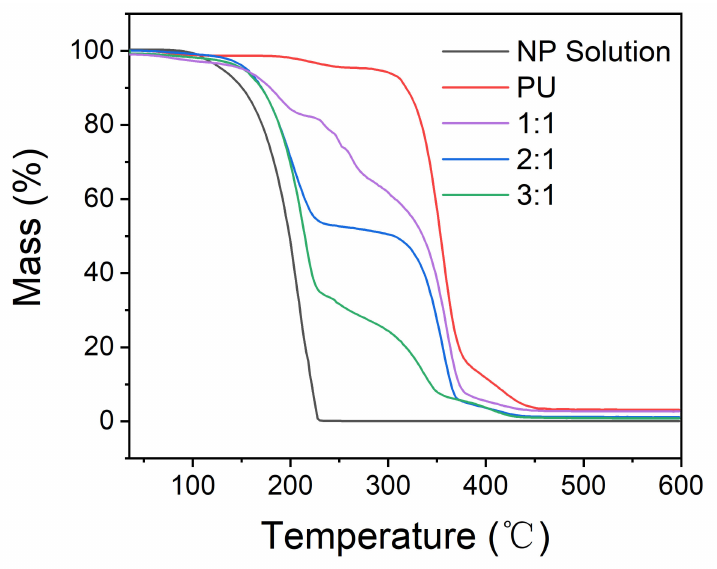
Figure 7. TGA curves of PU, NP solution, and microcapsules with core/shell ratio of 1:1, 2:1, and 3:1.